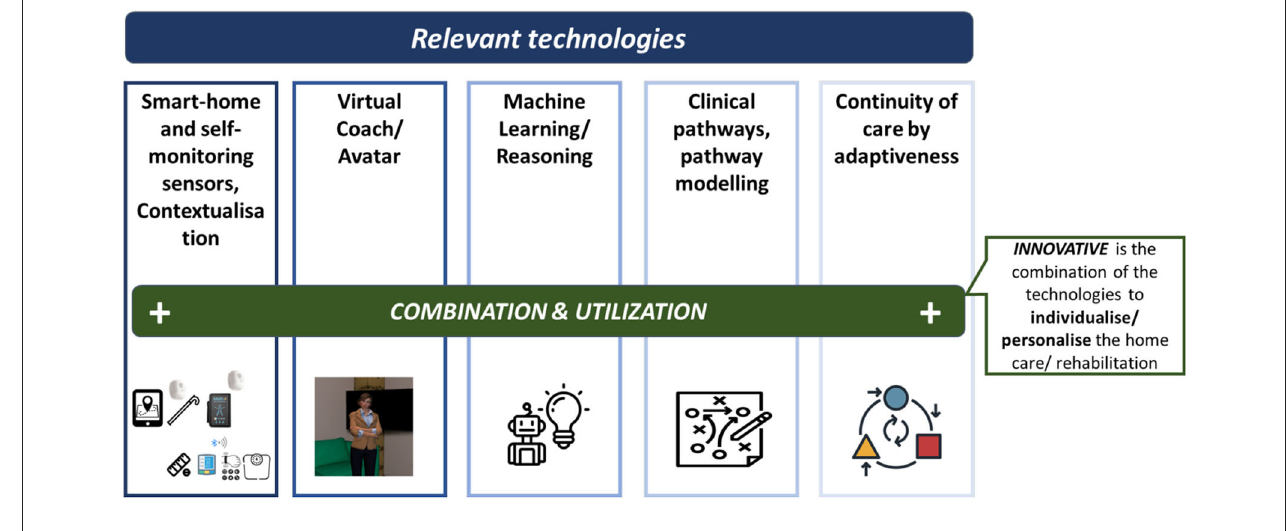
FIGURE 3 | Combining different technologies as an innovative element of vCare.